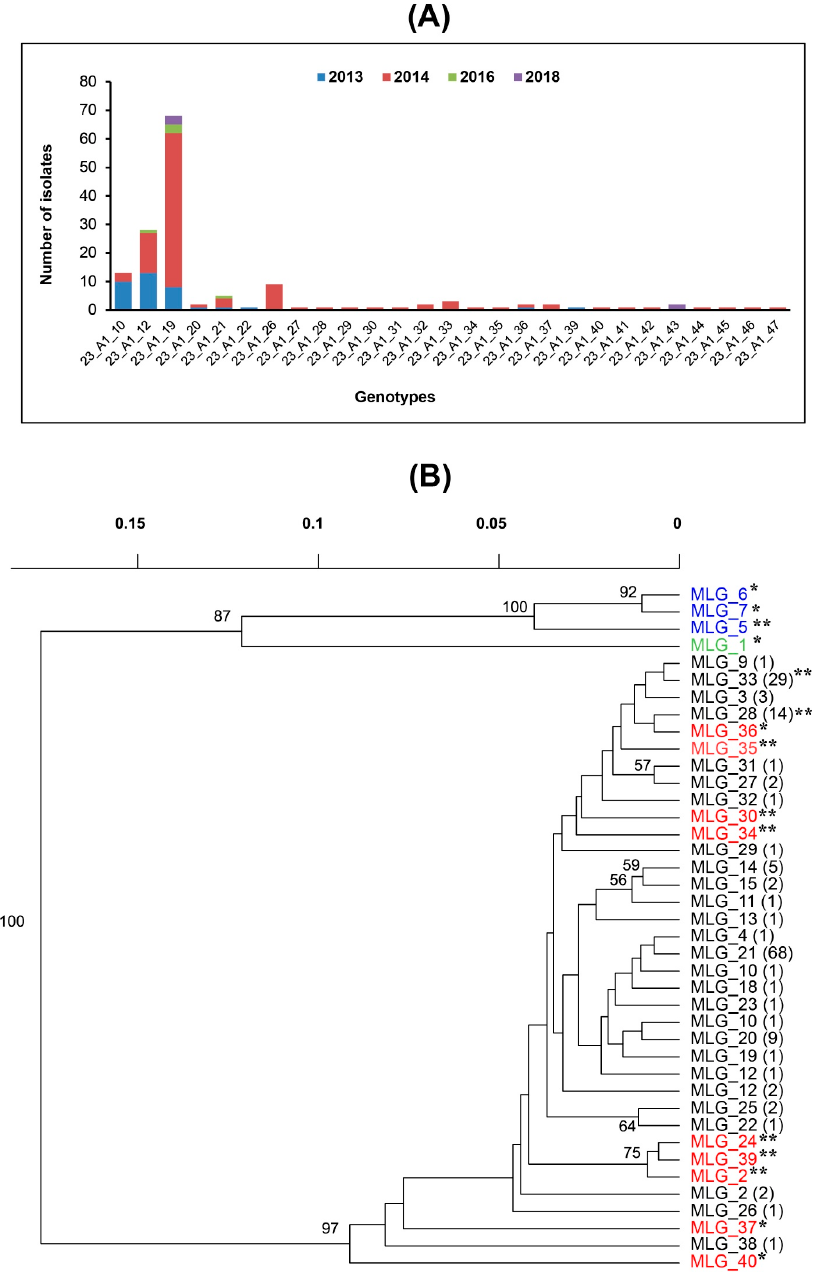
Figure 6. Number of isolates across Egyptian P. infestans populations according to MLGs, detected by 12 SSR markers. ( A ) The frequency of the 27 detected sub-clonal lineages over the 4 years. ( B ); Phylogenetic tree of the multi-locus genotypes (MLGs) of 23_A1 sampled in this study in comparison to reference isolates of 23_A1 (in red), the clonal lineage 13_A2 (blue) and a single isolate of another MLG of no known clonal lineage (green). The 23_A1 reference samples from previous work in Egypt are in red with a single asterisk representing isolates from 2010 and a double asterisk for subisolates from 2011. The numbers in brackets refer to the number of samples of each